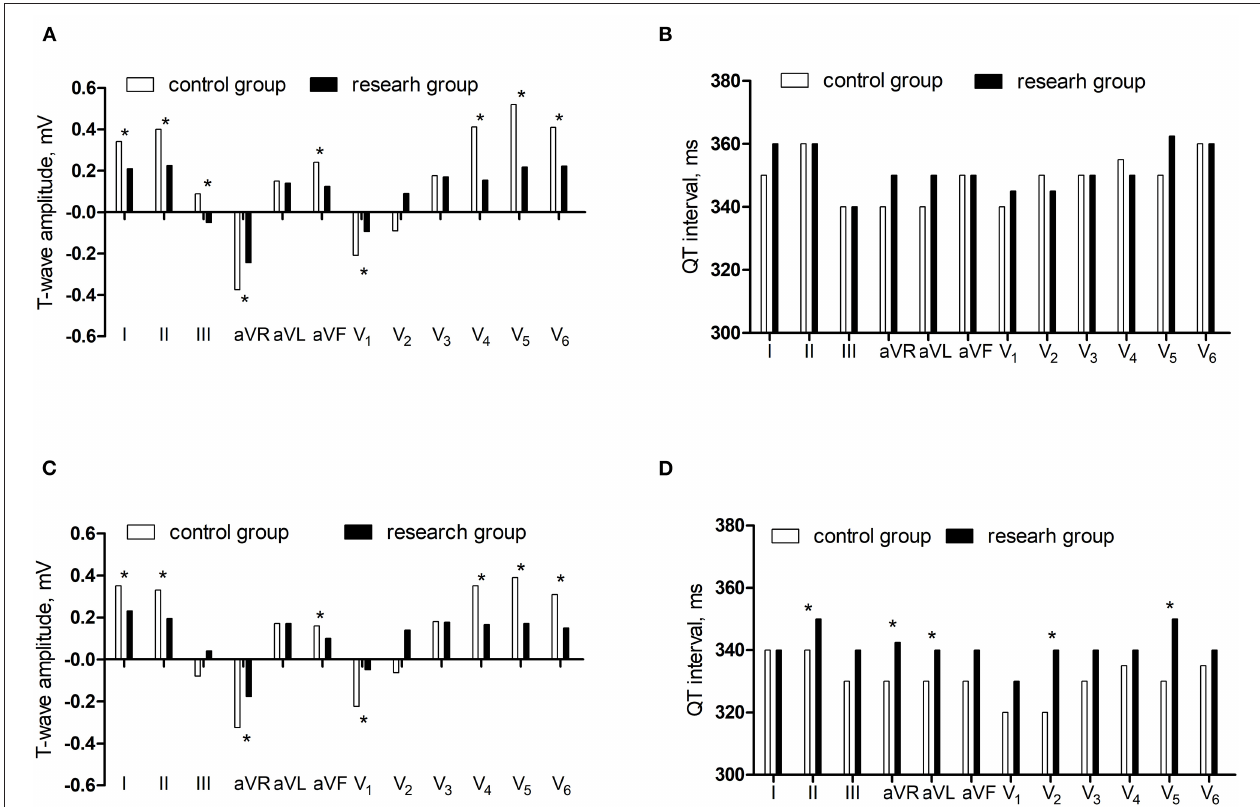
FIGURE 2 | The comparisons of T-wave amplitude and QT interval between control group and research group. (A) The T-wave amplitude in the supine ECG. (B) The QT interval in the supine ECG. (C) The T-wave amplitude in the orthostatic ECG. (D) The QT interval in the orthostatic ECG.* P < 0.05.